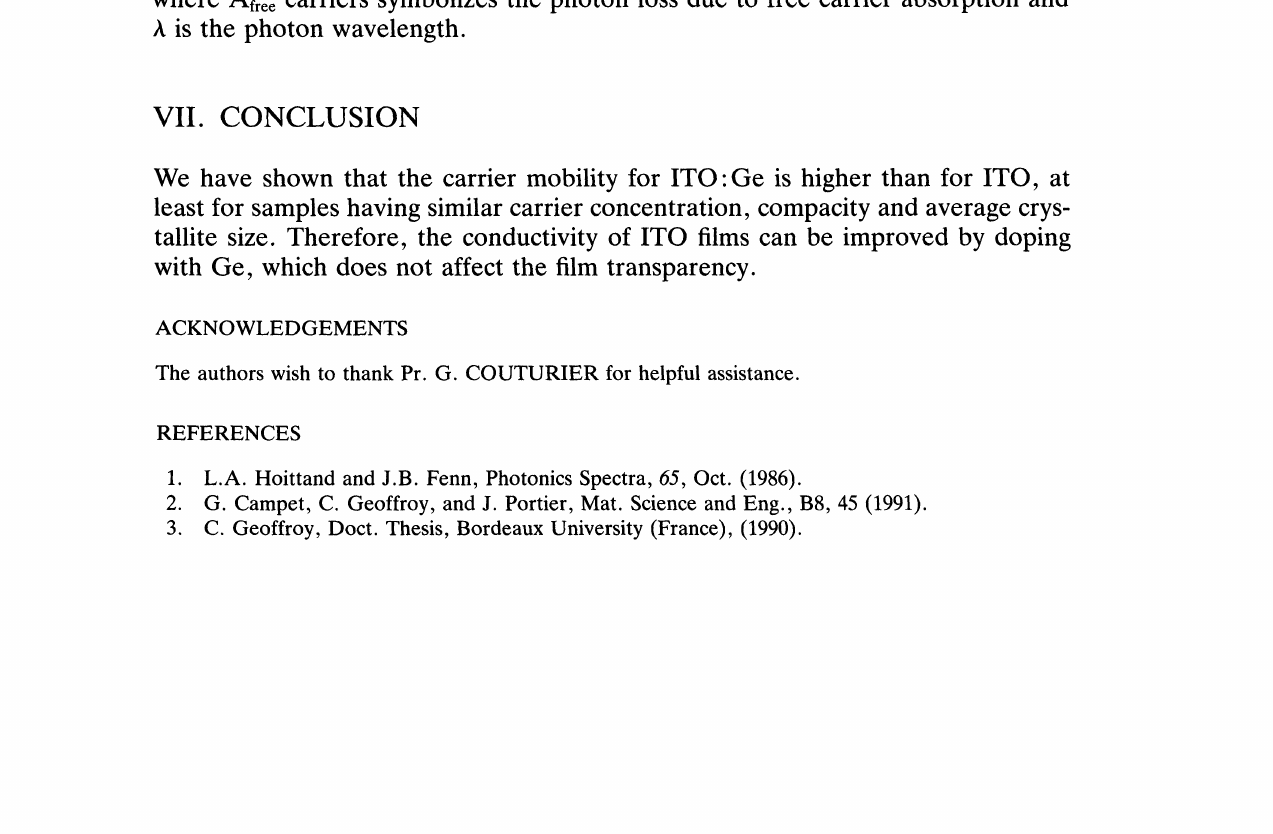
FIGURE 2 Transmission and reflexion spectra of 2000/ thick ITO and ITO’Ge lilms deposited on glass